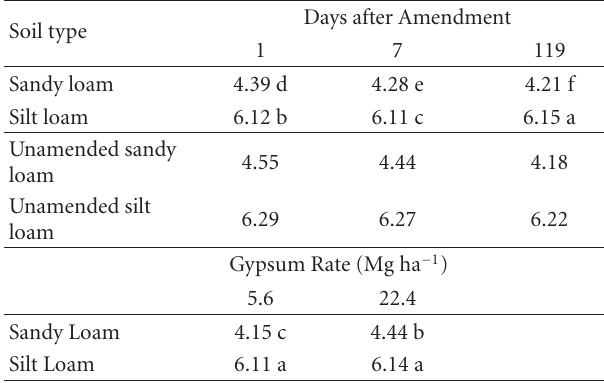
Table 4: Combined e ff ect of soil type and time averaged across phosphorus (P) saturation level and gypsum rate and combined e ff ect of soil type and gypsum rate averaged across time on soil pH †